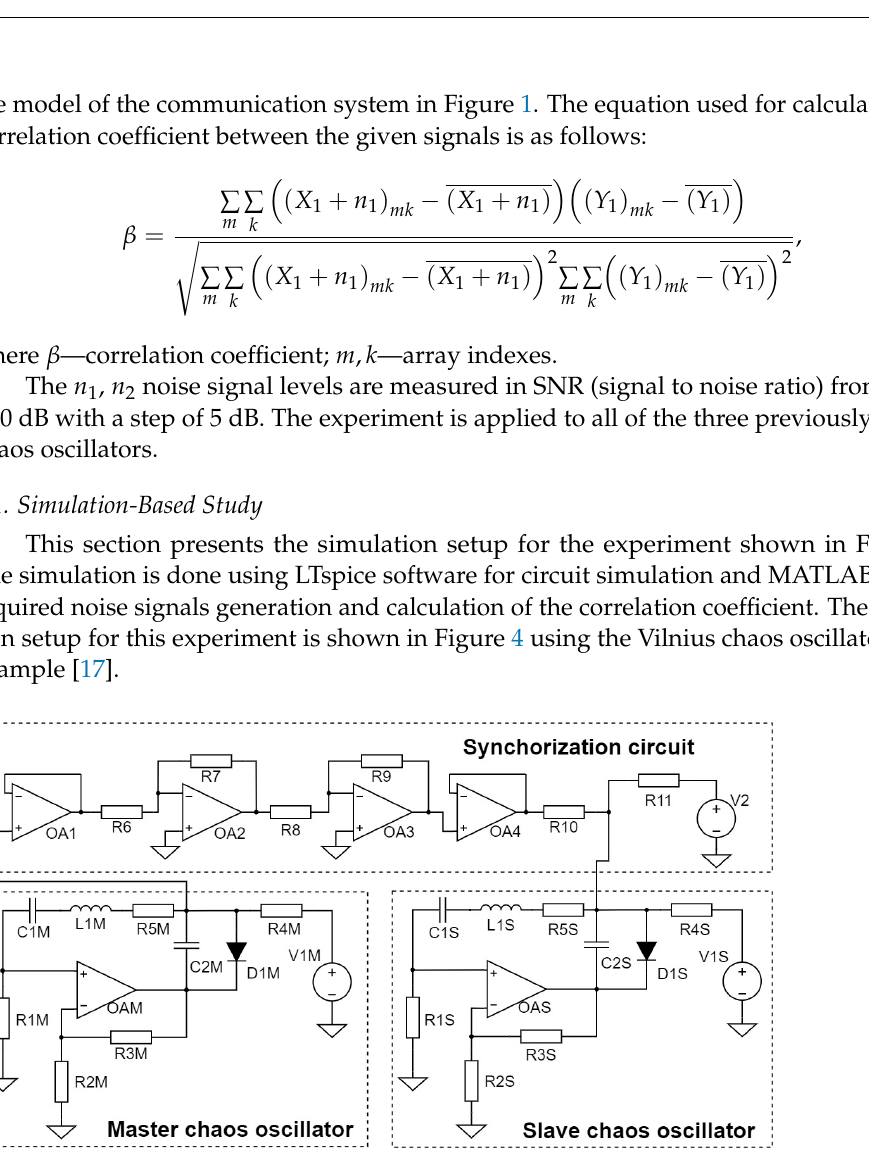
Figure 4. Simulation setup for the experimental study of the noise immunity chaos oscillator’s synchronization with a pair of Vilnius chaos oscillators as an example [17].